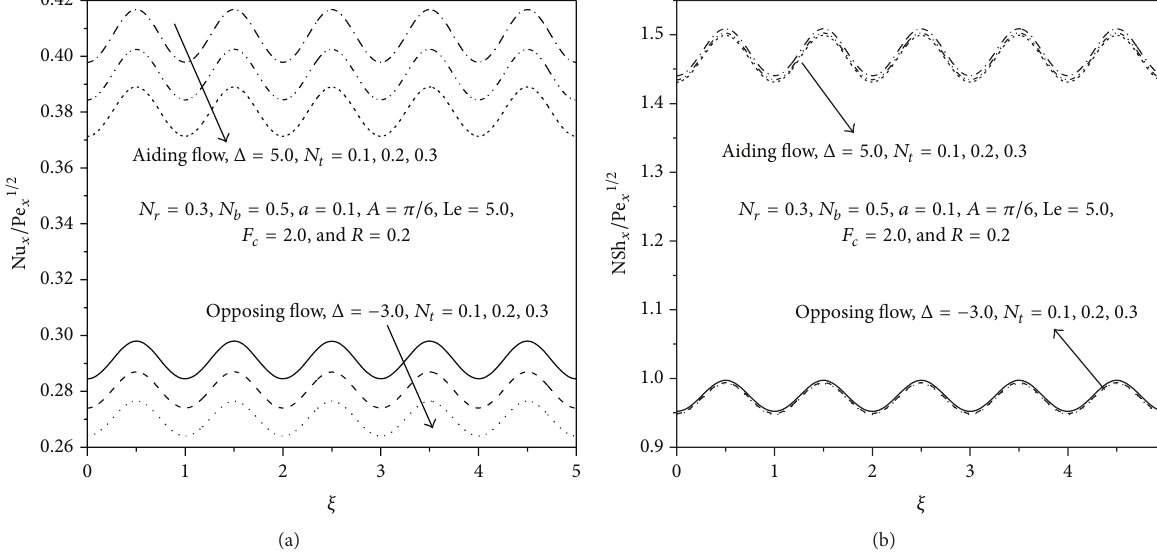
equations are transformed into a set of ordinary